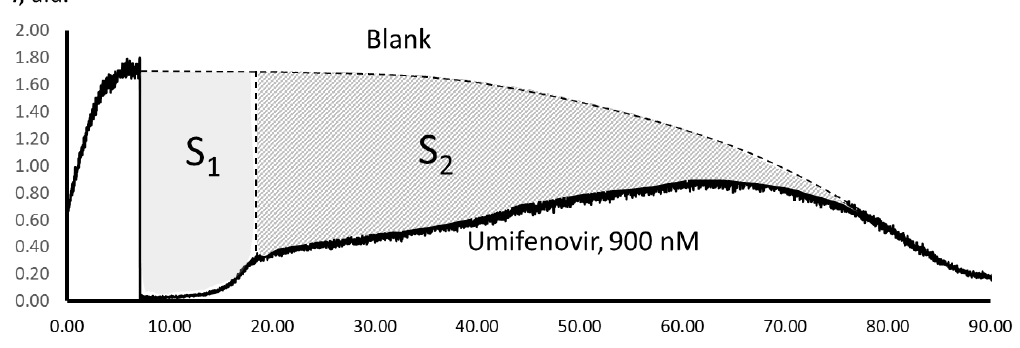
Figure 4. Calculation of the total antioxidant potential S of Umifenovir as a sum of S 1 and S 2 , where S 1 is the area of the “fast” part of chemiluminescence depression, S 2 is the area of the “slow” part of chemiluminescence depression. The plots are obtained for 900 nM that is a maximum concentration of Umifenovir in blood after oral administration of 200 mg.